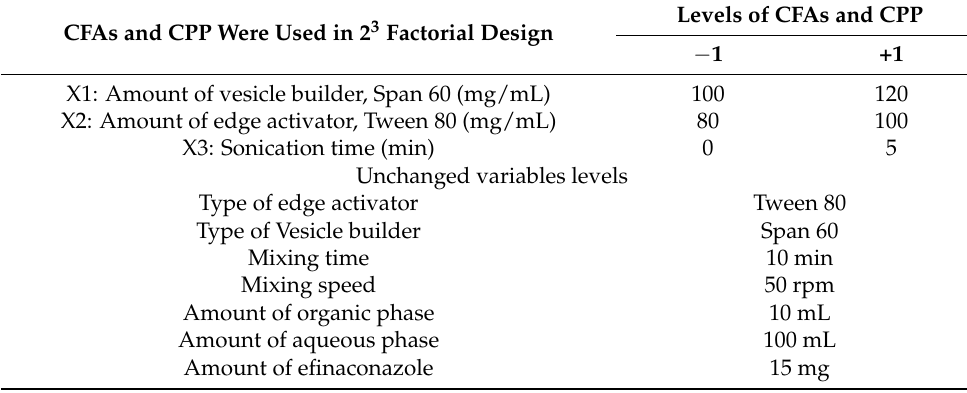
Table 3. 2 3 Full Factorial Design used in the experiment.